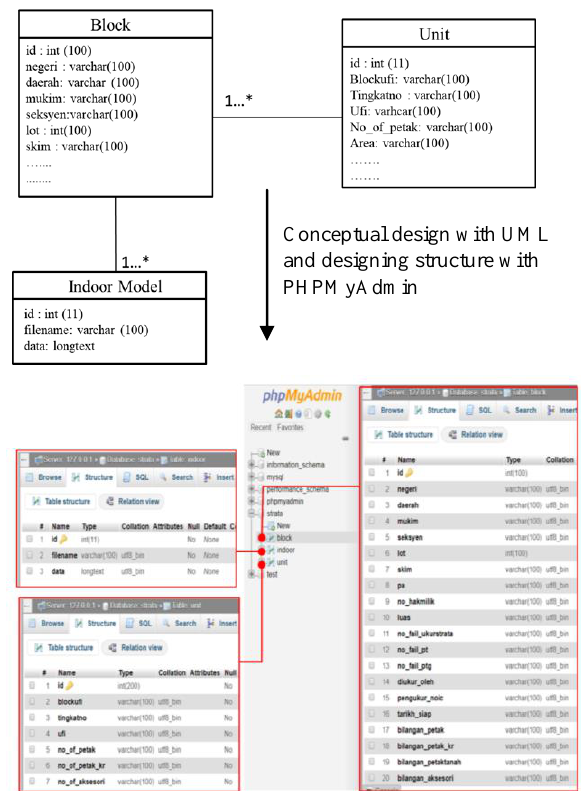
Figure 6. UML conceptual design and data